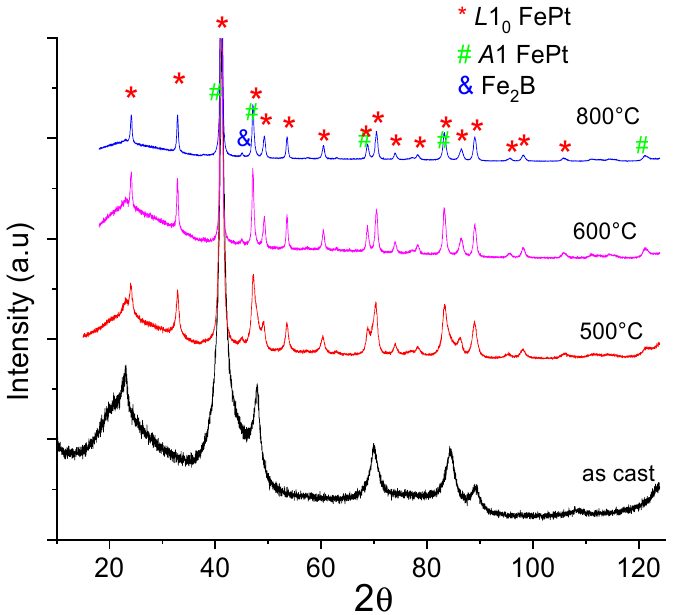
Figure 4. X-ray diffractograms of the Fe 65 Pt 15 Zr 3 B 17 sample, in its as-cast state as well as annealed at various temperatures (500 °C, 600 °C and 800 °C).